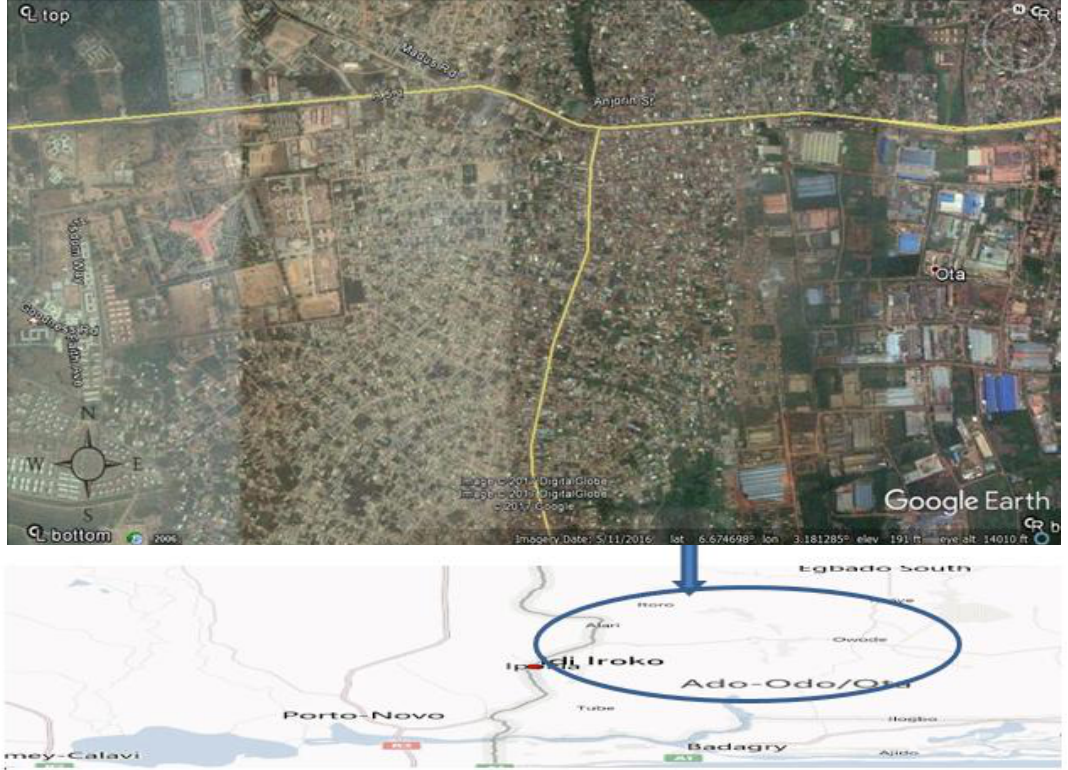
Fig. 1: Map of Ado Odo